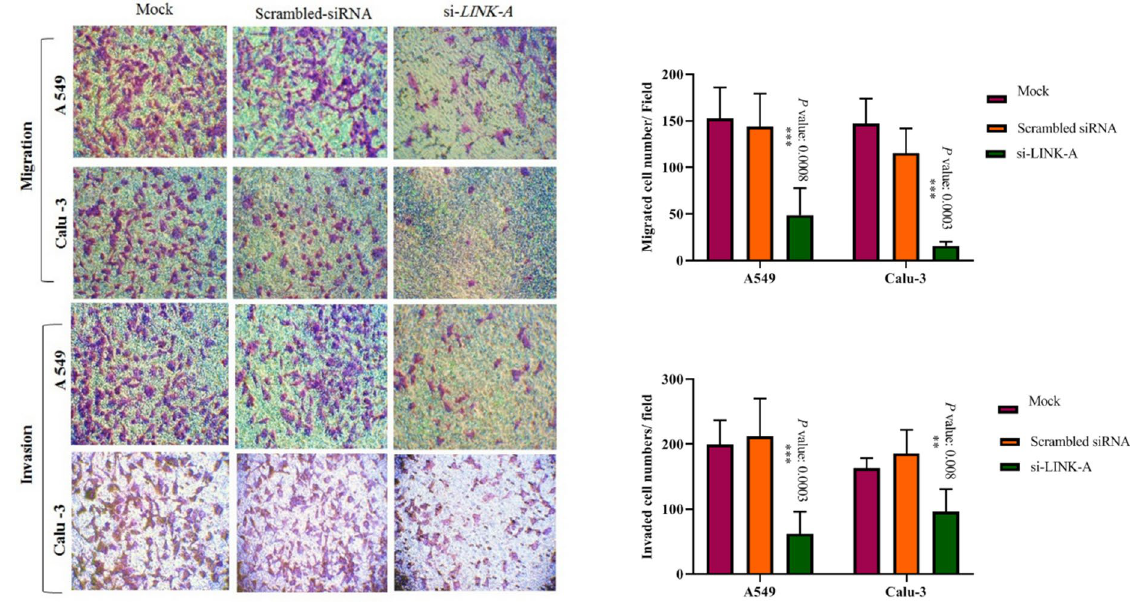
Figure 4. Effect of down-regulation of LINK-A on migration and invasion of A549 and Calu-3 cell lines using transwells. Note. Transwell and matrigel coated transwells were used to determine LINK-A suppression effect on migration and invasion ability of cells compared with controls for each cell line. si- LINK-A are cells transfected with pool 100 nM LINK-A siRNA, which were seeded on transwell inserts 24 hours later from transfection. Traversed cells at the bottom side of the chambers were photographed with 200× magnification after 48 hours and were counted in 5 different random fields. Data are presented as mean ± SD (*** P value <